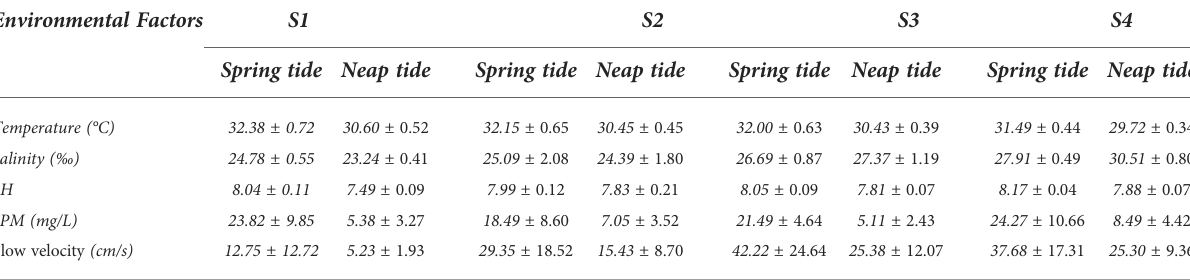
TABLE 1 Mean values of environmental factors for each station of